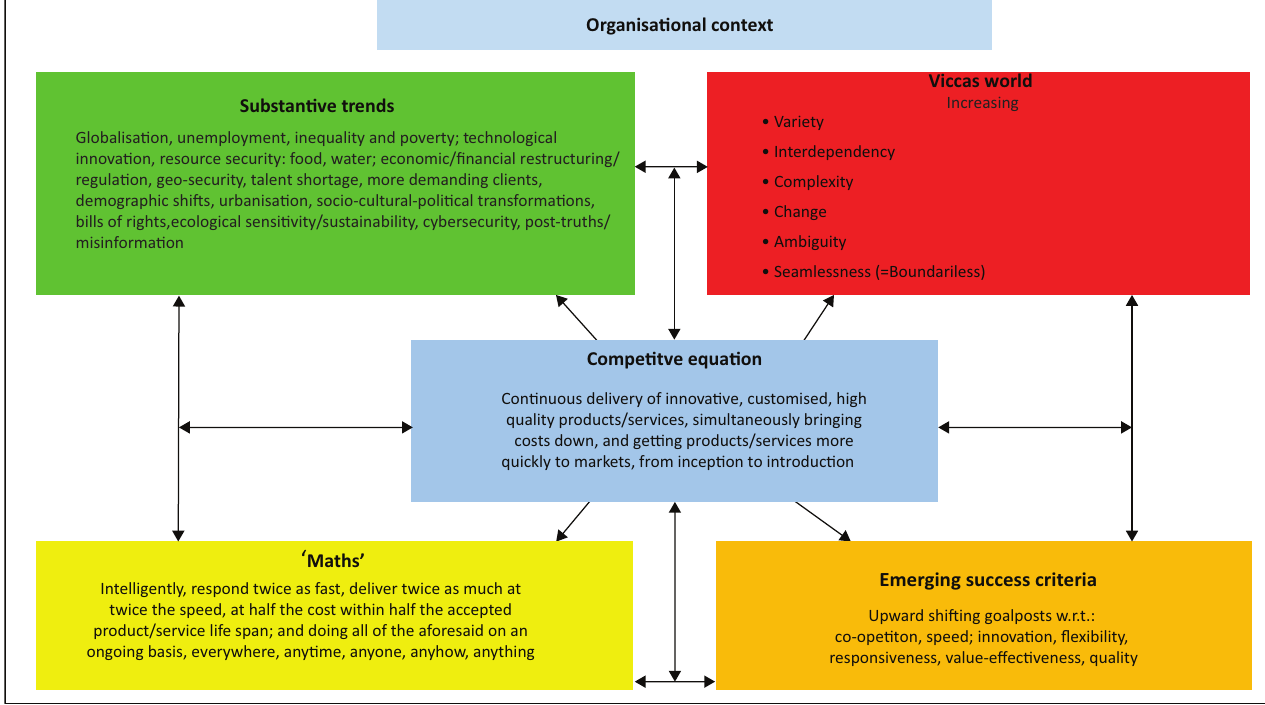
FIGURE 1: Emerging, new